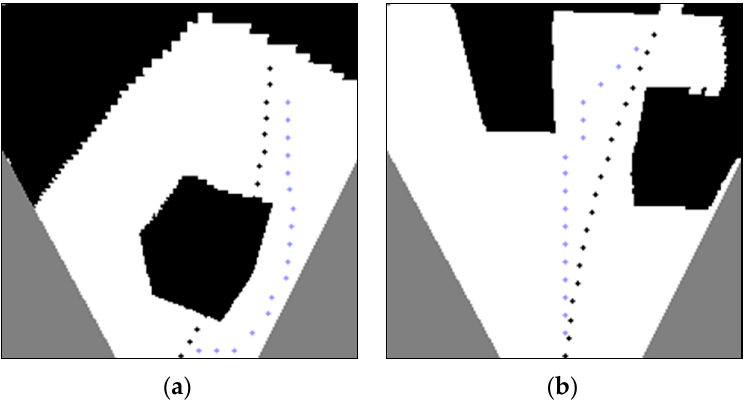
Figure 20. Effect of the smooth cost in the enhanced A* path: ( a ) having one obstacle at the bottom of the environment, ( b ) having two obstacles at the top of the environment.